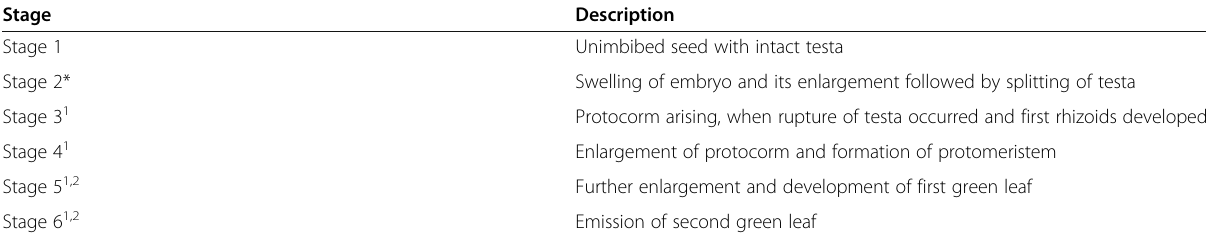
Table 1 Description of developmental stages during orchid seeds germination, according [23] with some alterations concerning stage 2 (marked*)